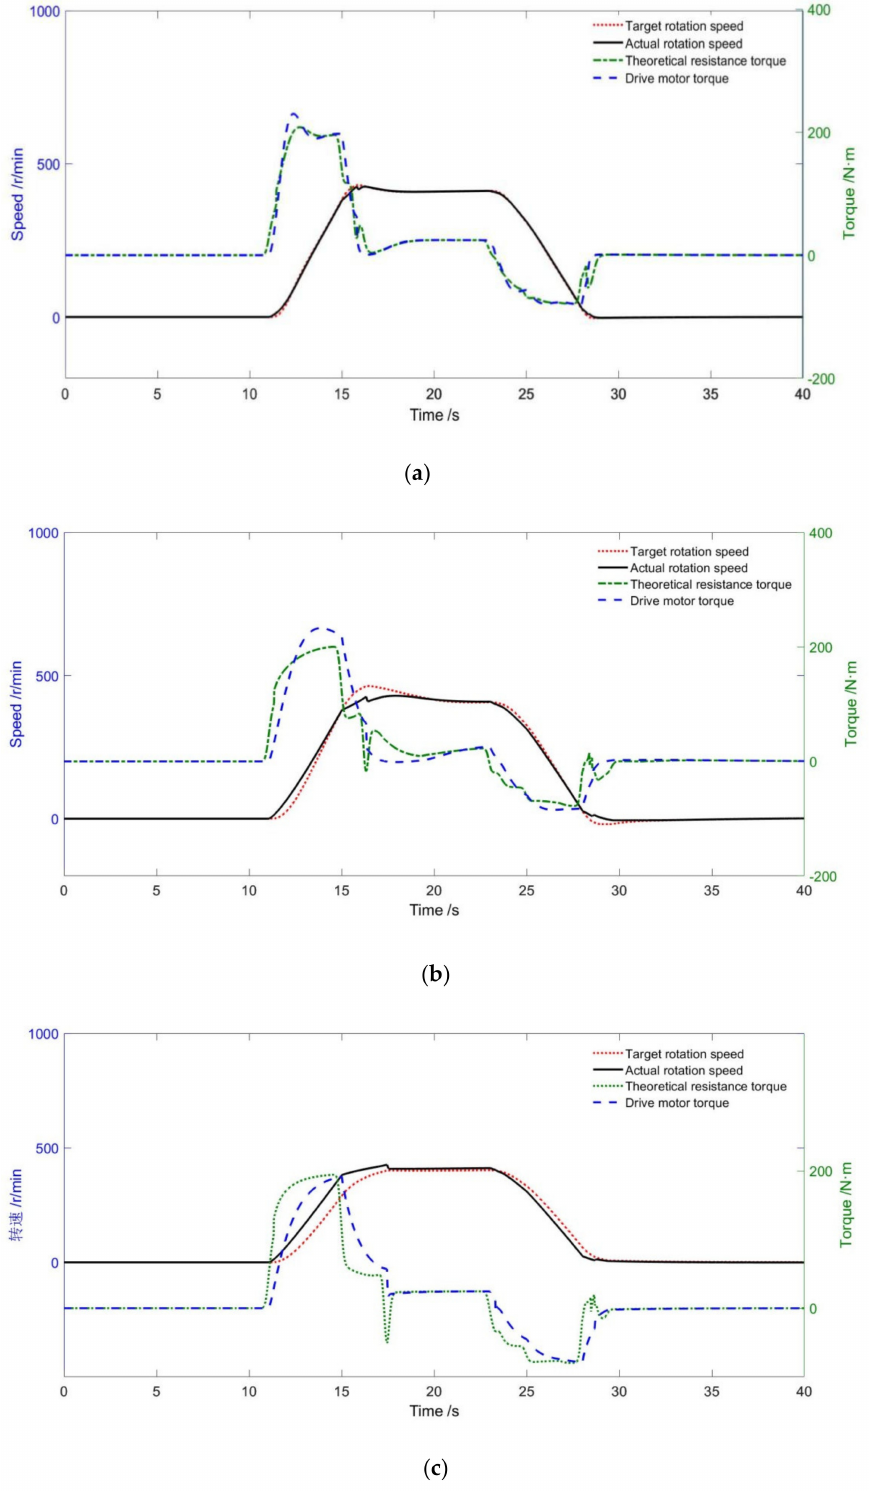
Figure 13. Simulation results of RLS with di ff erent sampling frequencies: ( a ) with penalty function when the sampling frequency is 10 Hz; ( b ) with penalty function when the sampling frequency is 1 Hz; ( c ) without penalty function when the sampling frequency is 100